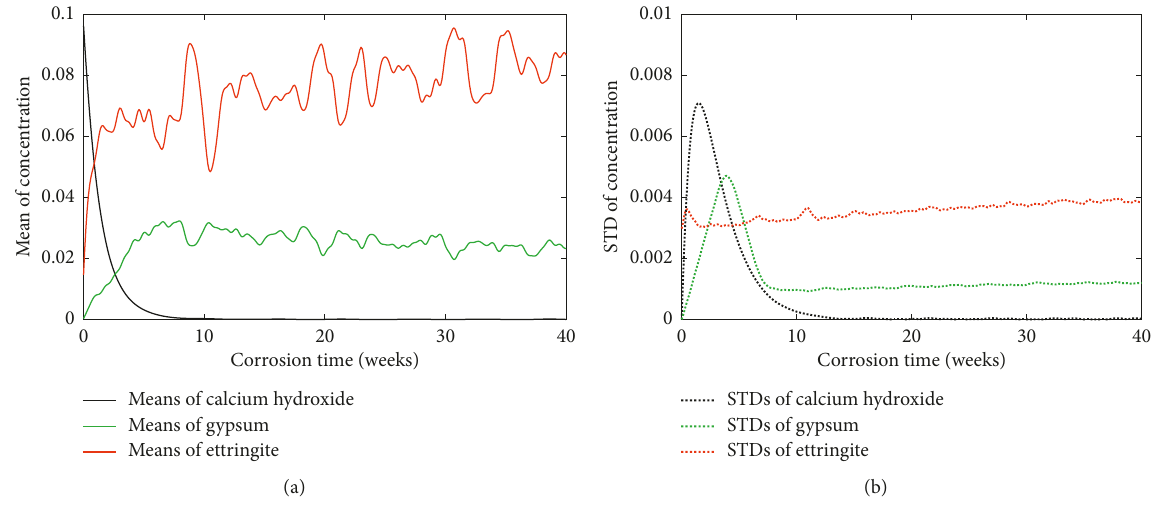
Figure 7: Means and STDs of the concentrations of three chemical constituents: (a) mean curve and (b) STD